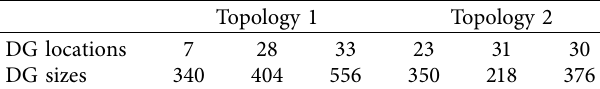
Figure 7: Proposed fow of work. Table 3: Optimal locations and sizes of DGs for 33-bus.